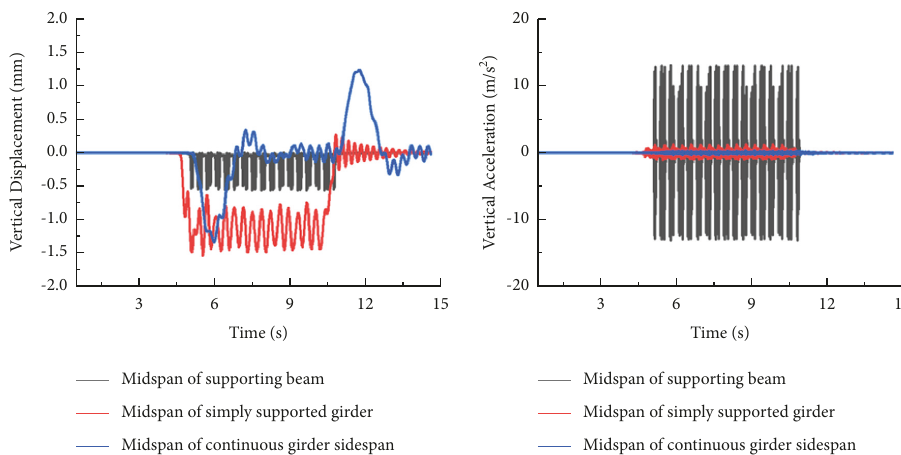
Figure 10: Time histories of the vertical dynamic response of BEJs and bridges adjacent to BEJs in Case